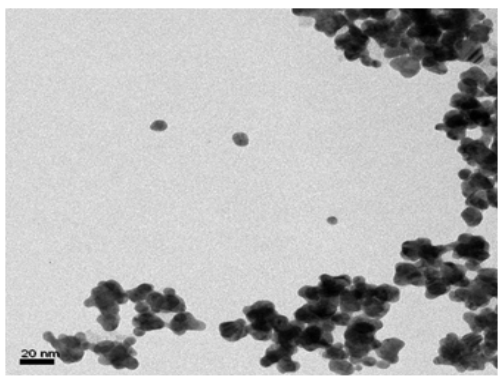
Figure 6. TEM image of GNPs.